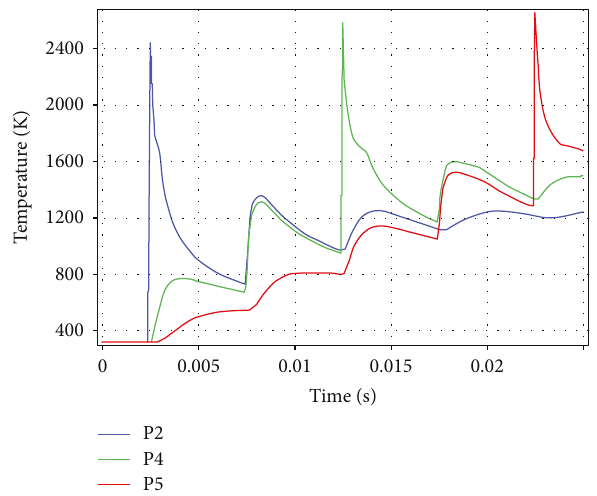
Figure 8: Global highest temperature variation curve.